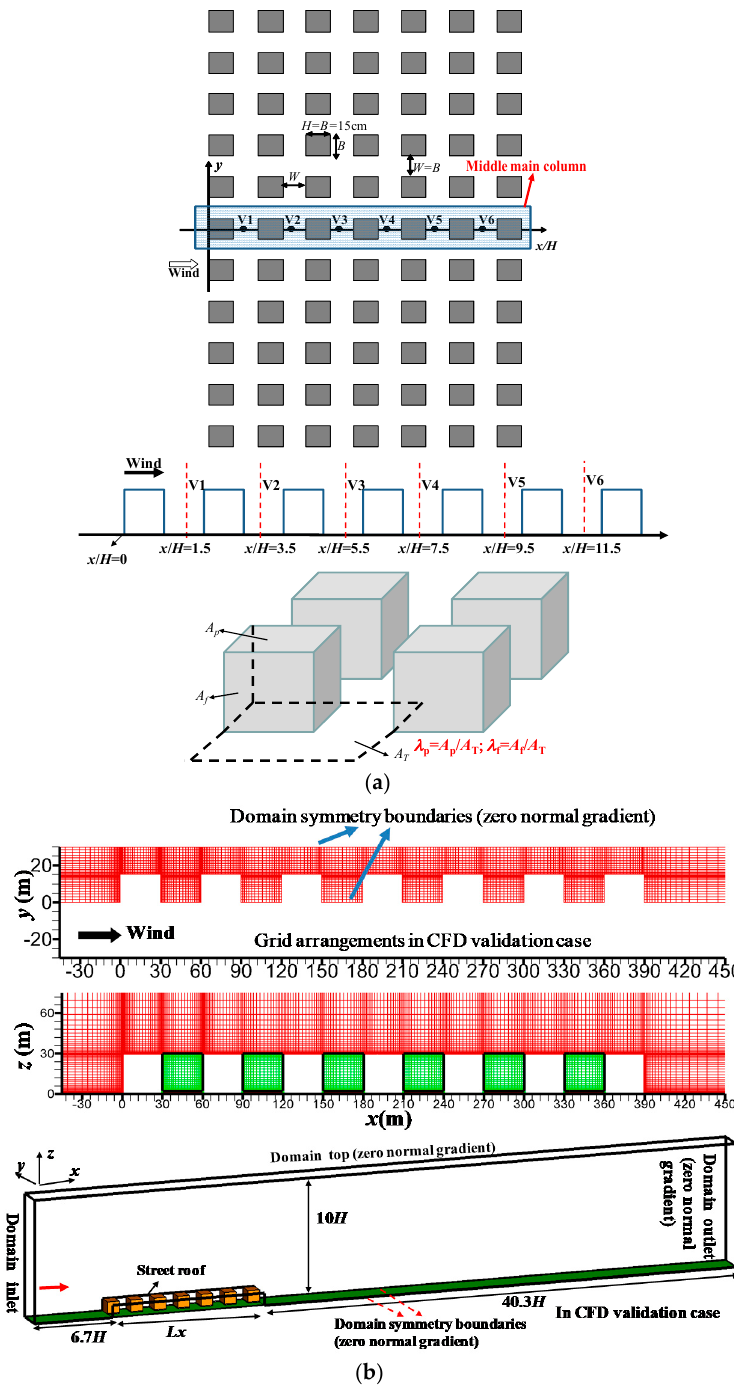
Figure 1. ( a ) Model description of wind tunnel test; ( b ) setups in CFD validation case.